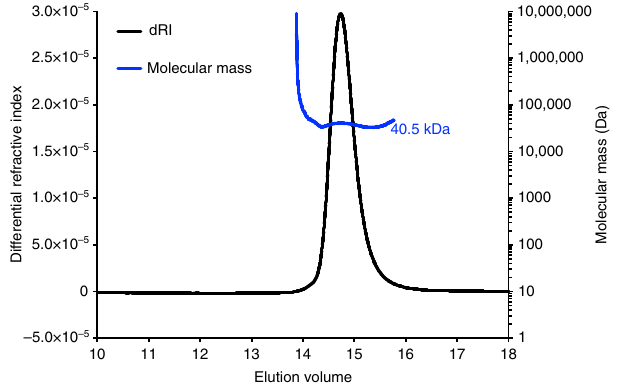
Fig. 4 Oligomeric state analysis of HPF long by SEC-MALLS. The Superdex 200 10/300 column (GE Healthcare) was equilibrated with 100 mM Tris-HCl, 150 mM NaCl (pH 8.0), and the protein was injected in the same buffer. The chromatogram (elution volume is indicated on the x axis) shows the readings of refractive index (RI) detector in black (the scale for the RI detector is shown in the left-hand axis). The thick blue line indicates the calculated molecular mass of the eluting protein throughout the chromatogram (scale on the right-hand axis). The calculated molecular weight is 40.5 kDa (molecular weight of a monomer is 21.3